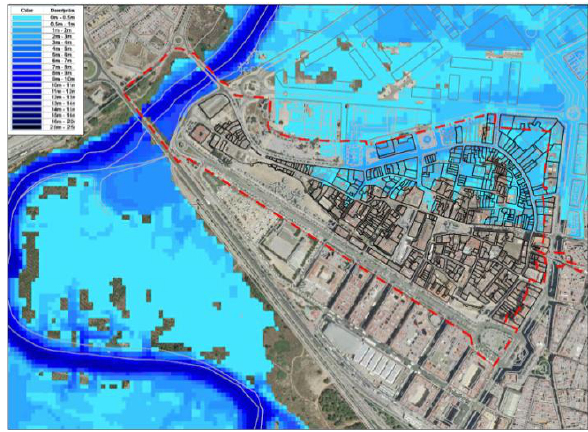
Figure 6. Draught levels. Return period of 100 years.